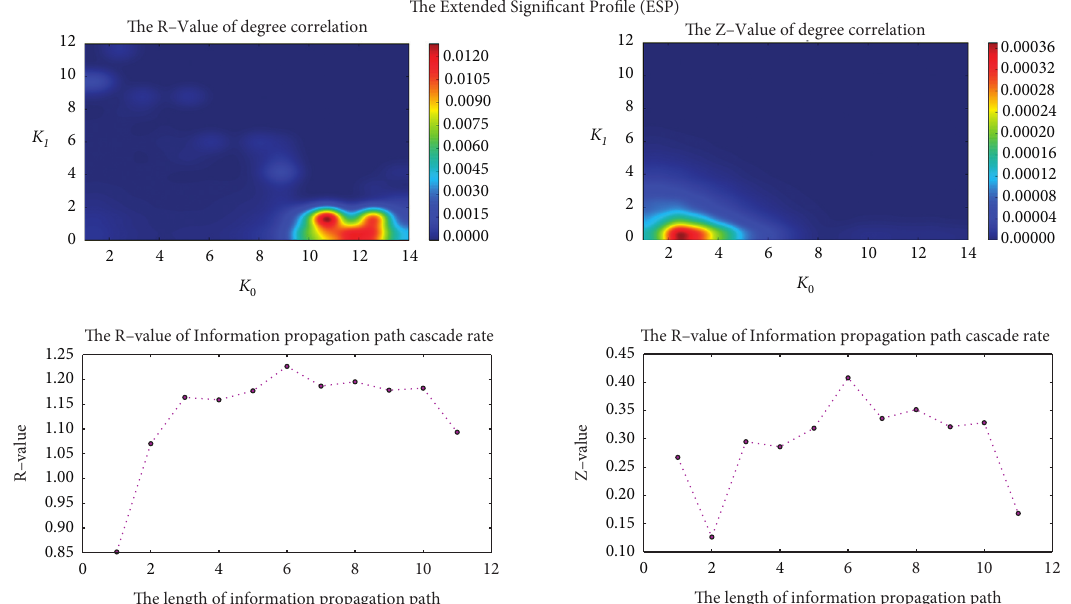
Figure 3: An example of extended significant profile [20]. This figure shows one example of an extended significant profile, i.e., the R -value and Z -value of degree correlation and the R -value and Z -value of the CRPs, which can be employed for analyzing the laws and patterns of information